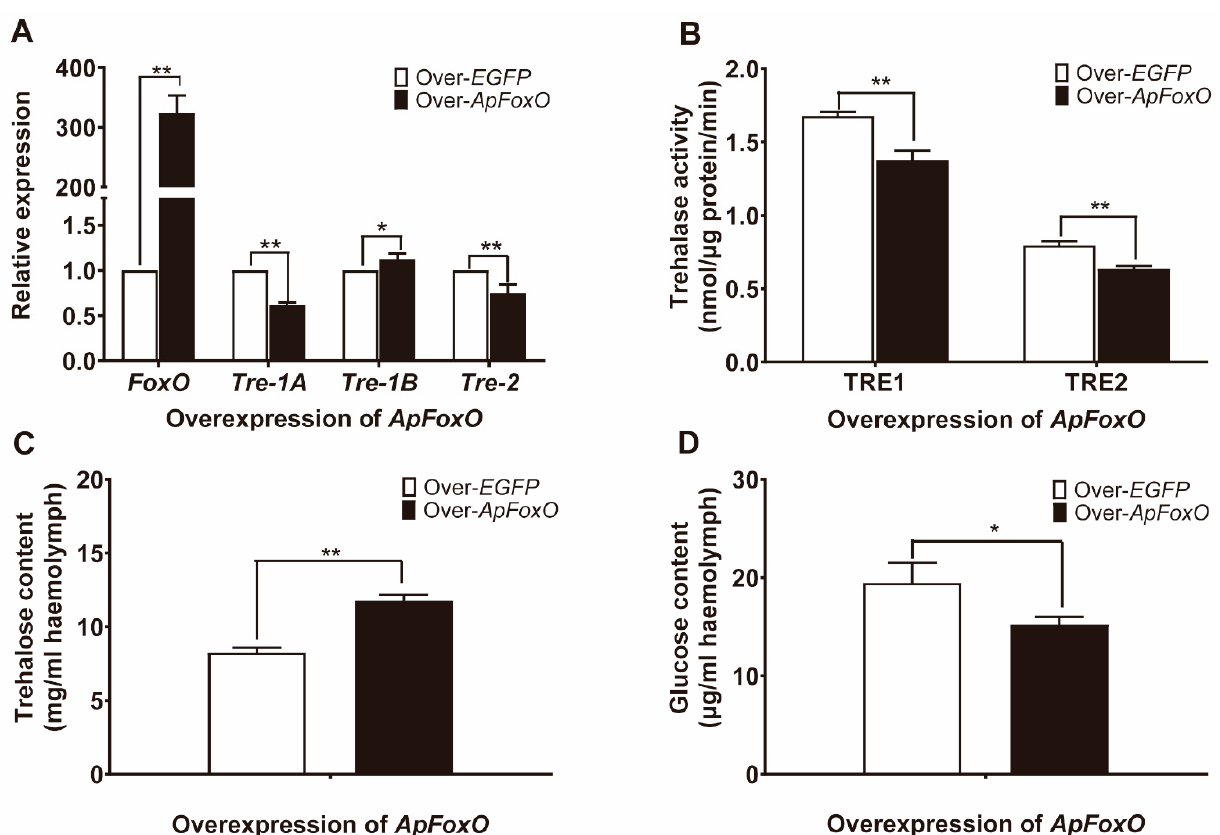
Figure 4. Overexpression of ApFoxO suppressed trehalose catabolism in A. pernyi pupae during diapause termination. All diapausing pupae were placed under the long-day photoperiod conditions (L:D 17:7) for 14 days to break diapause; then, they were injected with the recombinant virus ApNPV, containing either ApFoxO or EGFP cDNA under the promoter of the viral polyhedrin (polh) gene. Six days after the injection of baculovirus, pupae were collected for further analysis. ( A ) Relative expression levels of ApFoxO , ApTre-1A , ApTre-1B , and ApTre-2 . ( B ) Changes in soluble (TRE1) and membrane- bound (TRE2) trehalase activity. ( C , D ) Changes in trehalose and glucose levels, respectively, in the haemolymph. mRNA levels were normalised to those of the reference genes actin and RP49 , and the group used for the overexpression of EGFP served as controls. Data are means of three independent experiments, and error bars are SEs. Single asterisks ( p < 0.05) and double asterisks ( p < 0.01) represent significant differences between the ds EGFP and ds ApILP groups in the same time period.